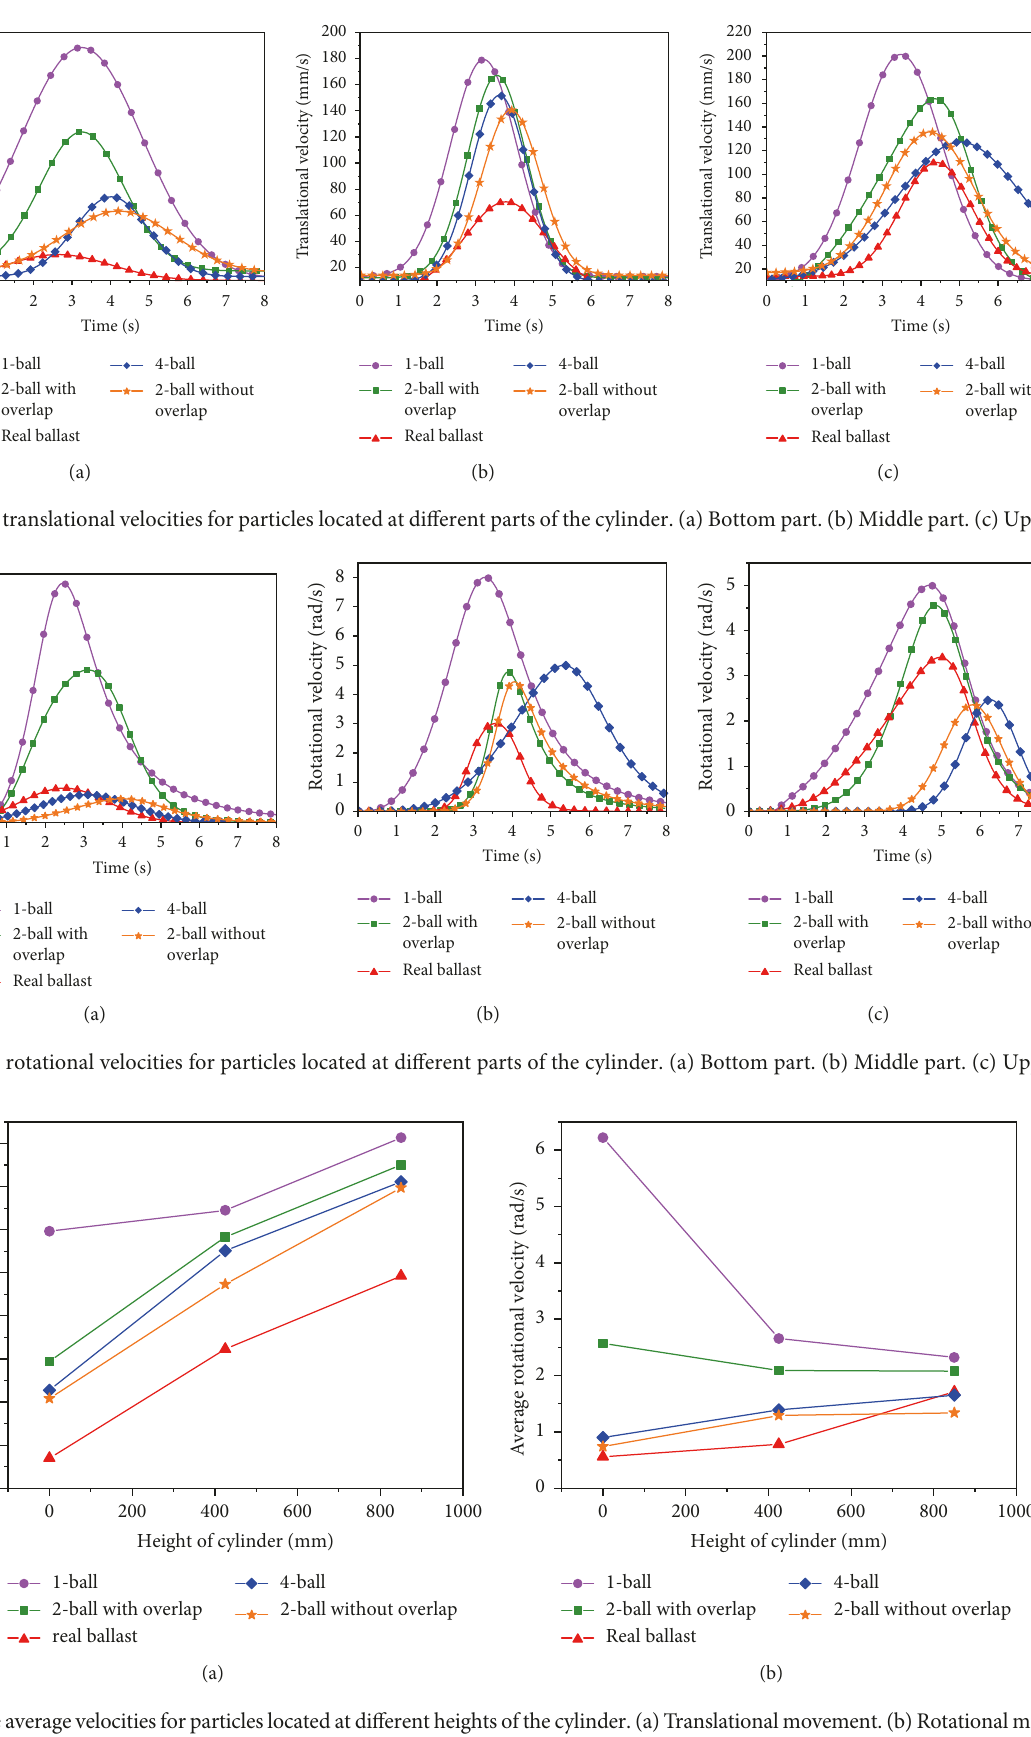
Figure 17: The average velocities for particles located at different heights of the cylinder. (a) Translational movement. (b) Rotational